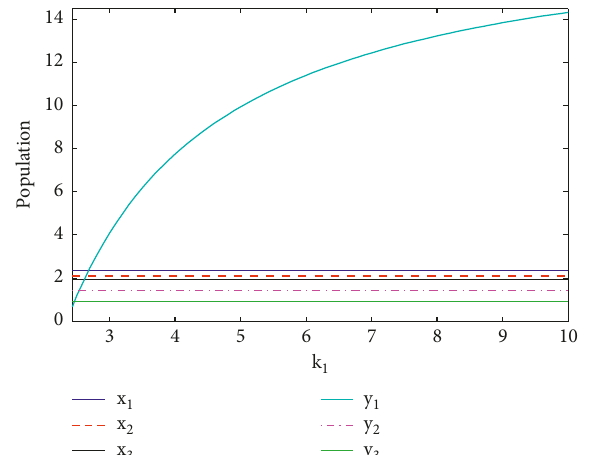
. Figure 6: Behaviour of all species with respect to k . 1